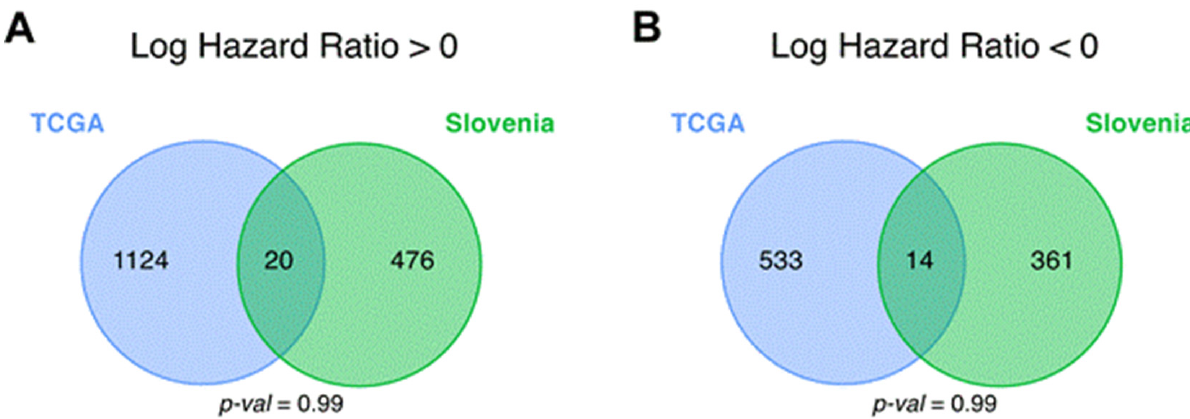
Figure 5. Intersections of differential ( A ) plus (hazard ratio > 0) and ( B ) minus (hazard ratio < 0) genes for progression-free survival (PFS) analysis between CGGA_325, CGGA_693 and TCGA glioblastoma samples.